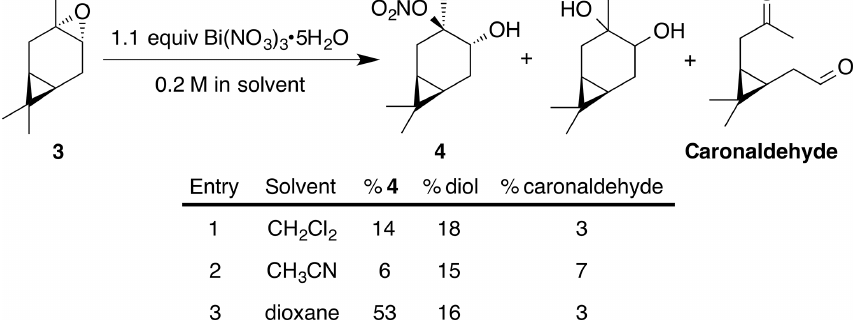
Figure 2. Effect of solvent on nitration of trans -3-carene oxide.